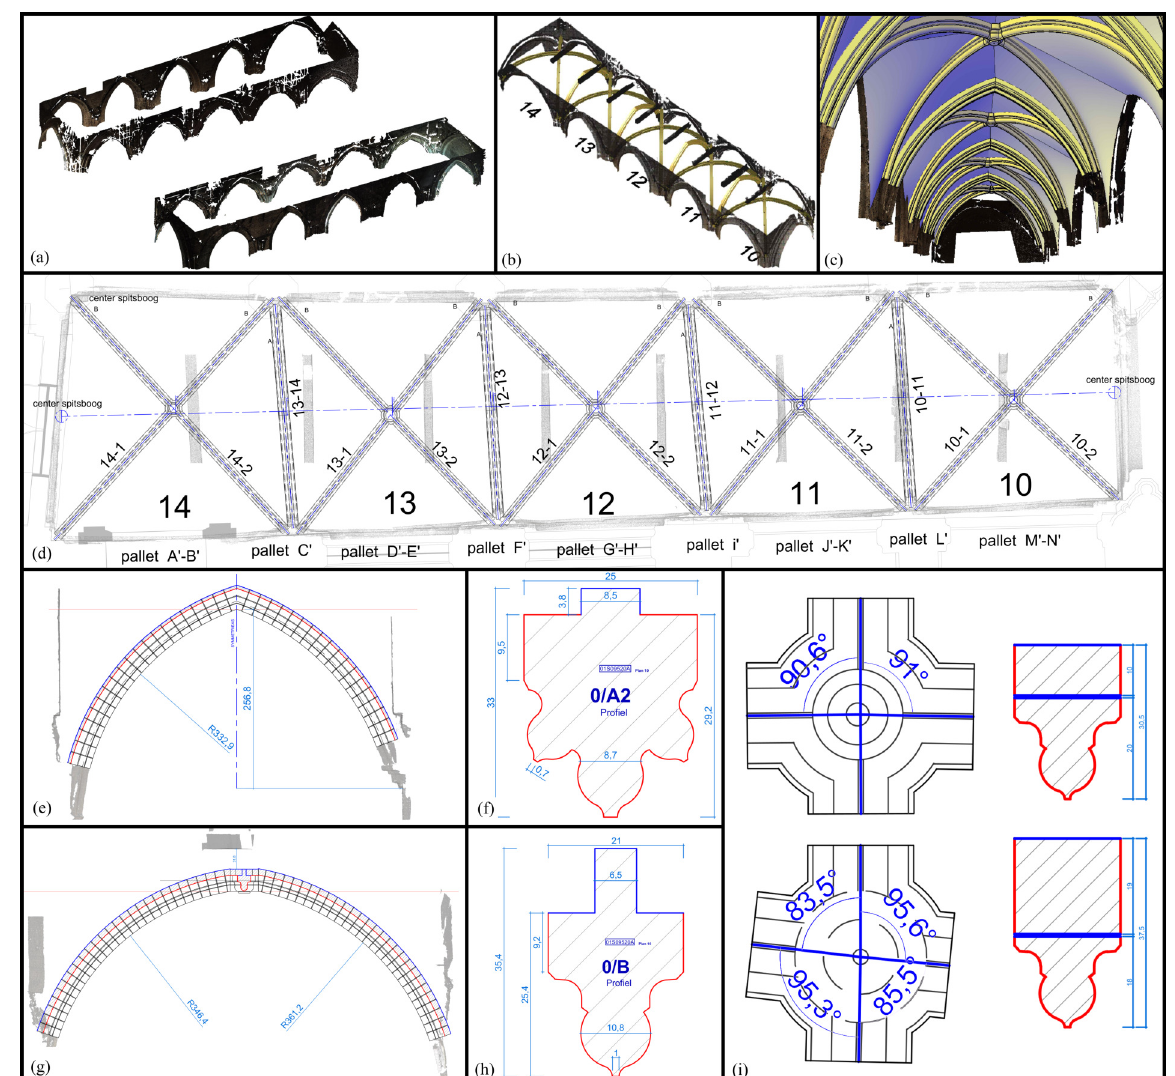
Figure 7: Subset of plan elements for the reconstruction of the vaults’ ribs. (a) Laser scanning result of the recorded current situation (b & c) 3D visualisations of the modelled rib vaults (d) 2D plan, note the asymmetrical characteristics of the structure due to differential settlements (e) plan for one of the pointed arches (f) stone profile for the pointed arches (g) plan for one of the vault ribs, note the different radii of the arch parts (h) stone profile for the vault ribs (i) designs for two replicas of rib vault centre keystones, note the large deviations from the ideally perpendicular 90 degrees